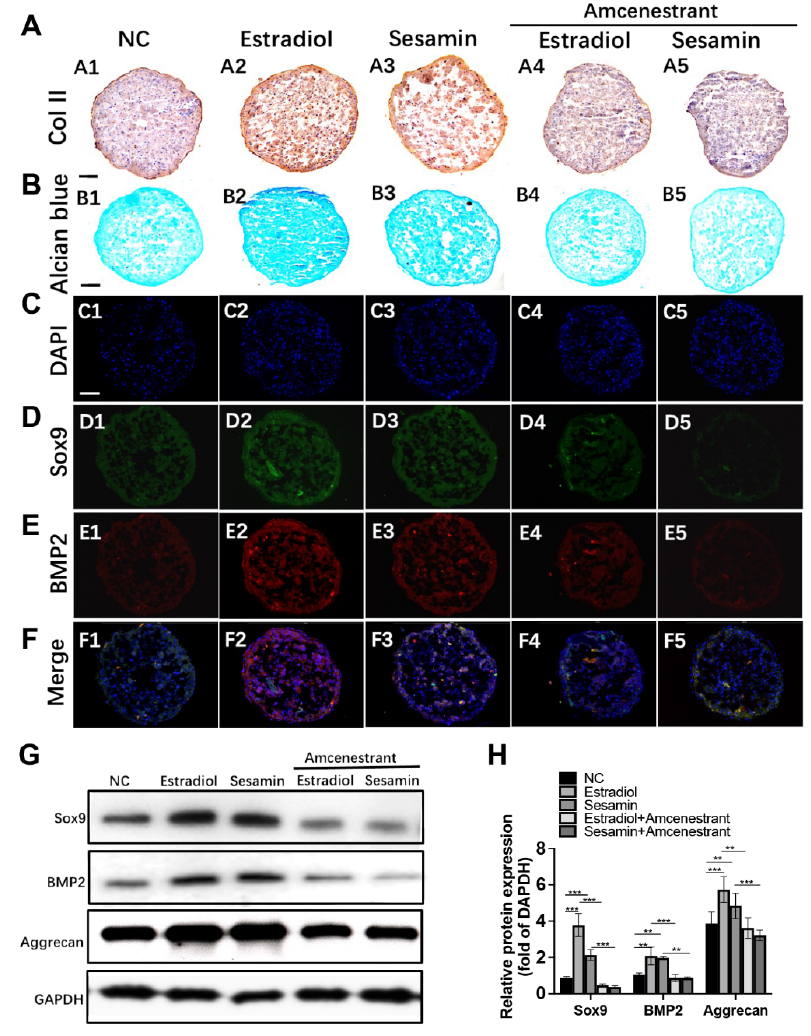
Figure 3. Sesamin promoted chondrogenesis of BMSCs in vitro: ( A ) IHC staining of BMSCs cell pellets under different treatments using Collagen type II antibody. ( B ) Alcian blue staining of cell pellets. ( C – F) . The IF staining of cell pellets using SOX9 ( D ) and BMP2 ( E ) antibodies. DAPI was used as a negative control ( C ). The figures were merged ( F ). ( G , H ) Western blot ( G ) and semi-quantitative analysis ( H ) of chondrogenesis markers expression after 21-day chondrogenesis induction ( n = 6; ** p < 0.01, *** p < 0.001).